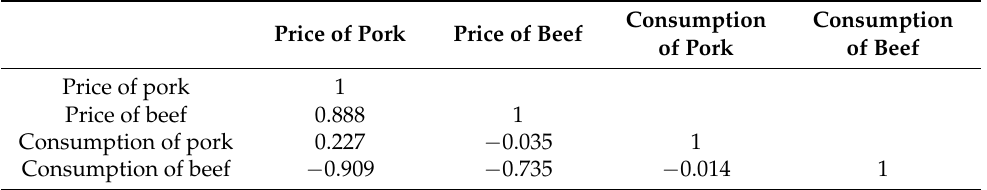
Table 3. Correlation analysis of the relationship between price and consumption of individual types of meat. Consumption Consumption Price of Pork Price of Beef of Pork of Beef Price of pork 1 Price of beef 0.888 1 Consumption of pork 0.227 − 0.035 1 Consumption of beef − 0.909 − 0.735 − 0.014